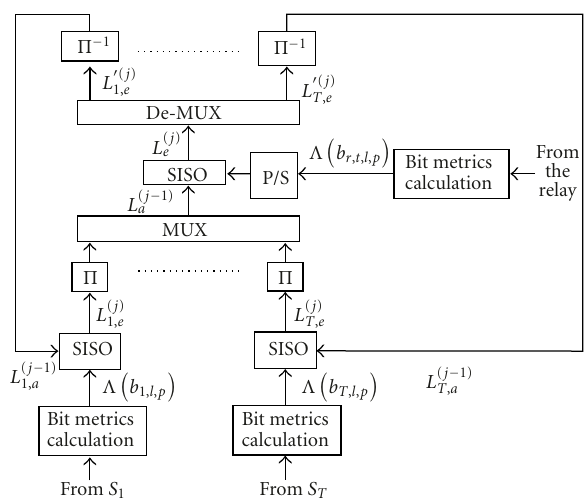
Figure 5: Multiuser joint iterative decoding for multiplexing transmission at the